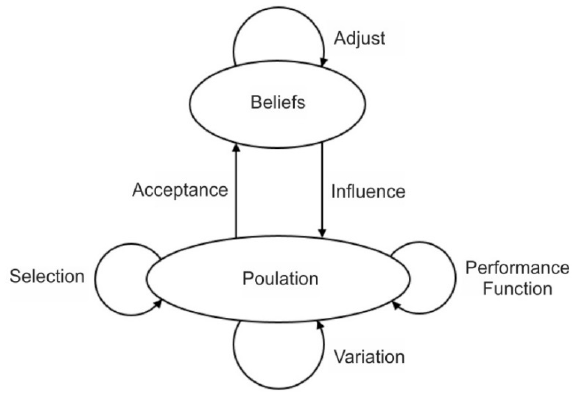
Figure 6. Spaces of a cultural algorithm [74].